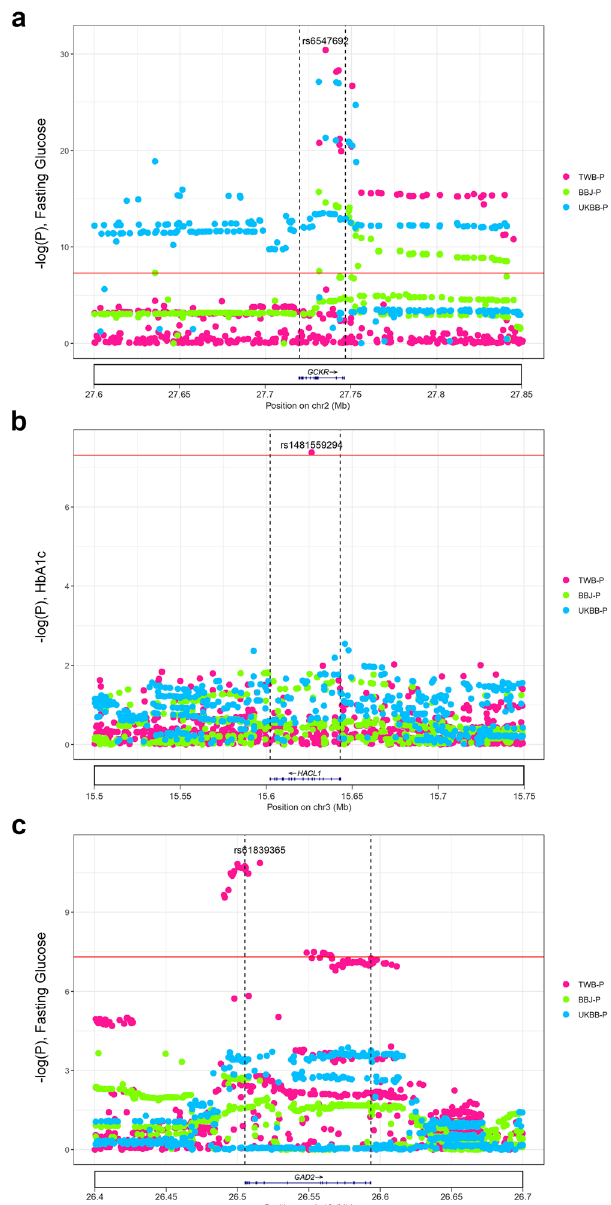
Fig. 5 Regional association plots, identi fi ed by comparison of Taiwan Biobank (TWB), Japan Biobank (BBJ) and UK Biobank (UKBB) genome- wide association studies (GWASs). The X axis represents the position of loci (hg19). The Y axis represents – log 10 (P). Red dots are P values of variants from TWB. Green dots are p values from the BBJ. Blue dots are P values from UKBB. The red horizontal line represents P = 5 × 10 − 8 . The black dashed line represents the location of the gene. a GCKR gene; b HACL1 gene; and c GAD2